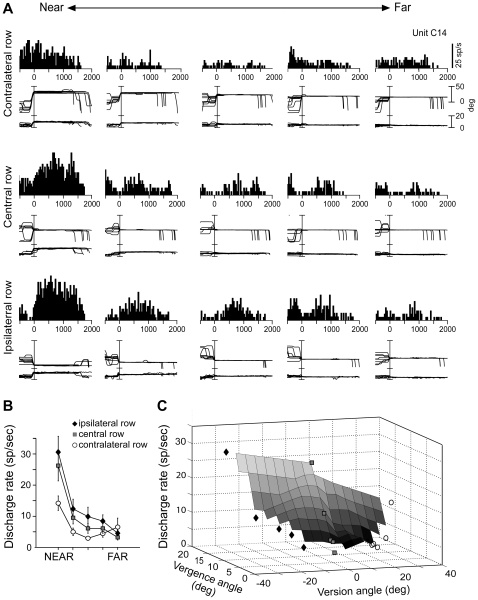
Example of a neuron with fixation activity modulated by depth.(A): Top/Middle/Bottom: neural responses and eye traces to the five LEDs of the contralateral/central/ipsilateral space arranged from near (left) to far (right), aligned at the end of the saccade. This cell prefers targets located at near and ipsilateral space. (B): Mean± s.e.m. discharge rates are shown for each LED of the contralateral (white circles), central (grey squares) and ipsilateral (black diamonds) row. (C): Three dimensional plot obtained by interpolating mean discharge rates for the average value of vergence and version of each LED of the contralateral (white circles), central (grey squares) and ipsilateral (black diamonds) row. Cell discharge reflects a strong tuning by vergence that is influenced by version, so that the cell is activated maximally for fixations on the nearest targets, especially in the ipsilateral space.